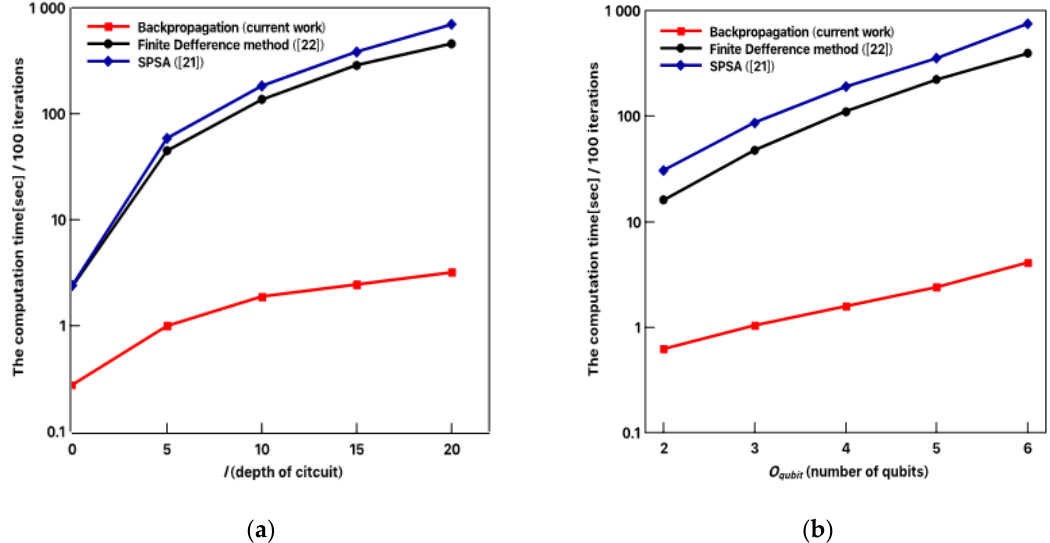
Figure 8. Comparison of computation cost for different approaches. ( a ) Computation cost dependence on the depth of the quantum circuit. ( b ) Computation cost dependence on the number of qubits.